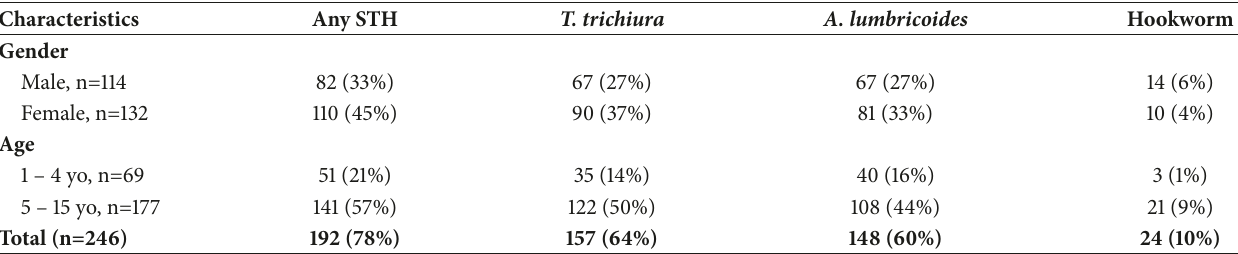
Table 1: The characteristics of subjects in Perobatang village, 2016.